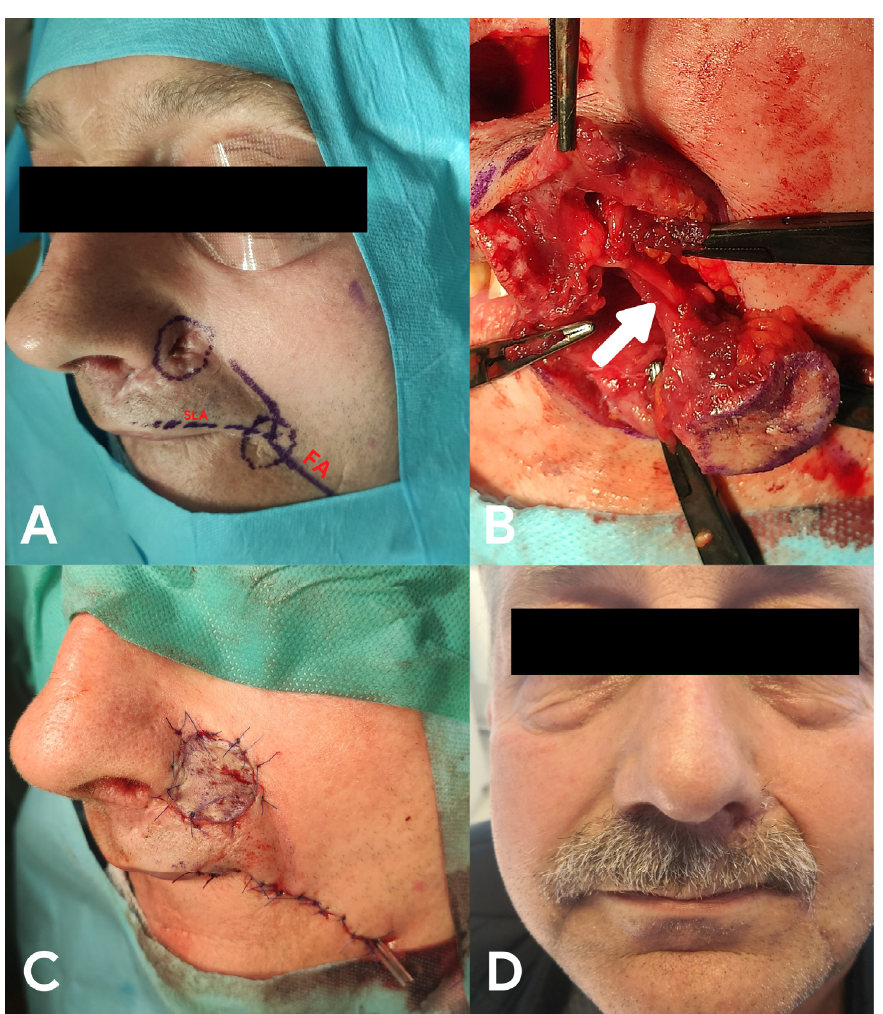
Figure 4. Recurrence of basal cell carcinoma of the upper part of the left nasolabial fold. ( A ) flap planning, FA—facial artery, SLA—superior labial artery, ( B ) pedicle of the flap (white arrow), ( C ) final reconstruction, and ( D ) patient 12 months after the surgery.